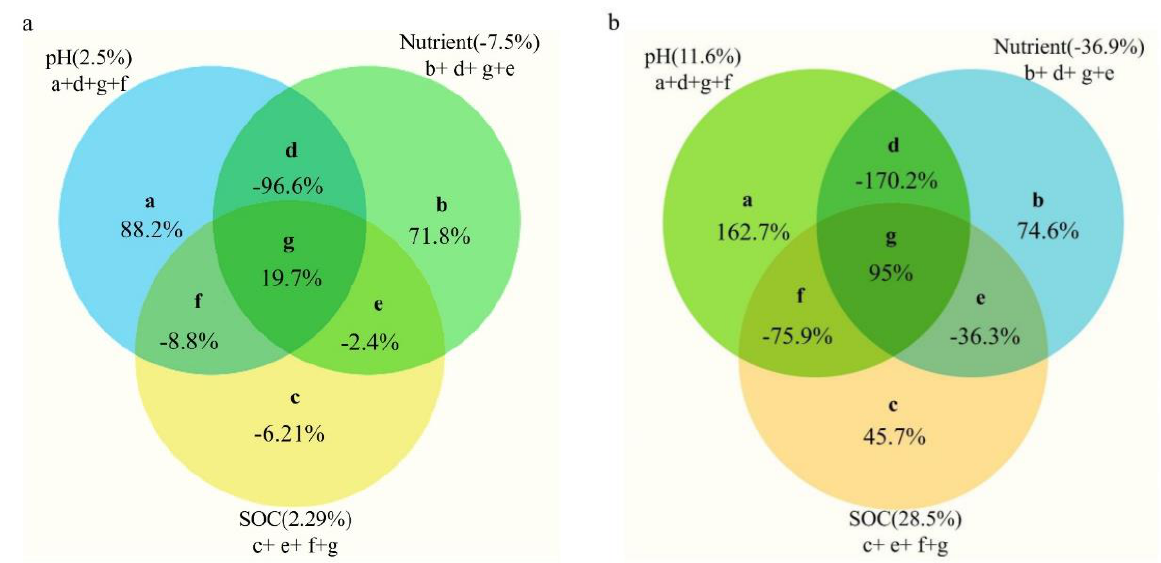
Figure 6. Variation partitioning results in the RDA of ‘Var-part-3groups-Conditional-effects-tested’. Different cover crops–biochar–organic fertilizer treatments ( a ) and different biochar–organic fertilizer treatments ( b ) groups are listed.